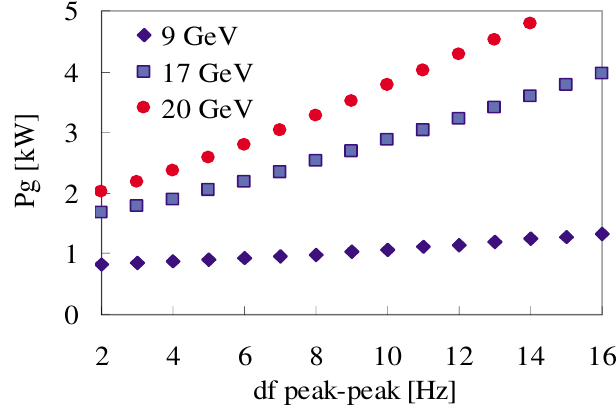
FIG. 17. (Color) rf power needed to operate SST without ER versus microphonics at three different final beam energies and beam current of 50 (cid:2) A .